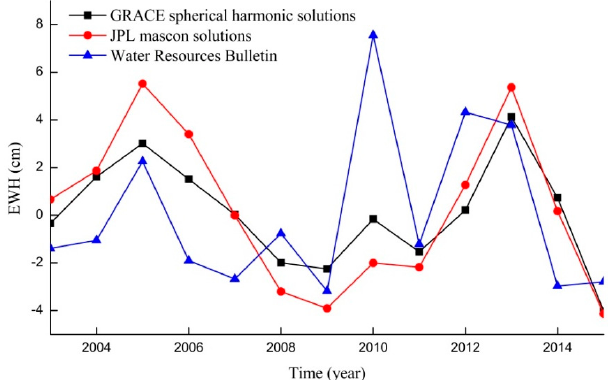
Figure 6. Comparison between the two solutions of GRACE TWSA and the Water Resources Bulletin of the Song Liao River